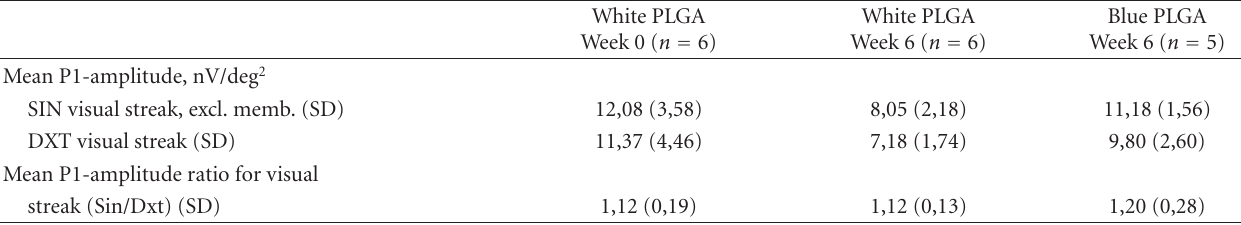
Table 2: Mean P1-amplitude values and ratios of visual streak obtained by multifocal electroretinogram before and 6 weeks after membrane implantation.